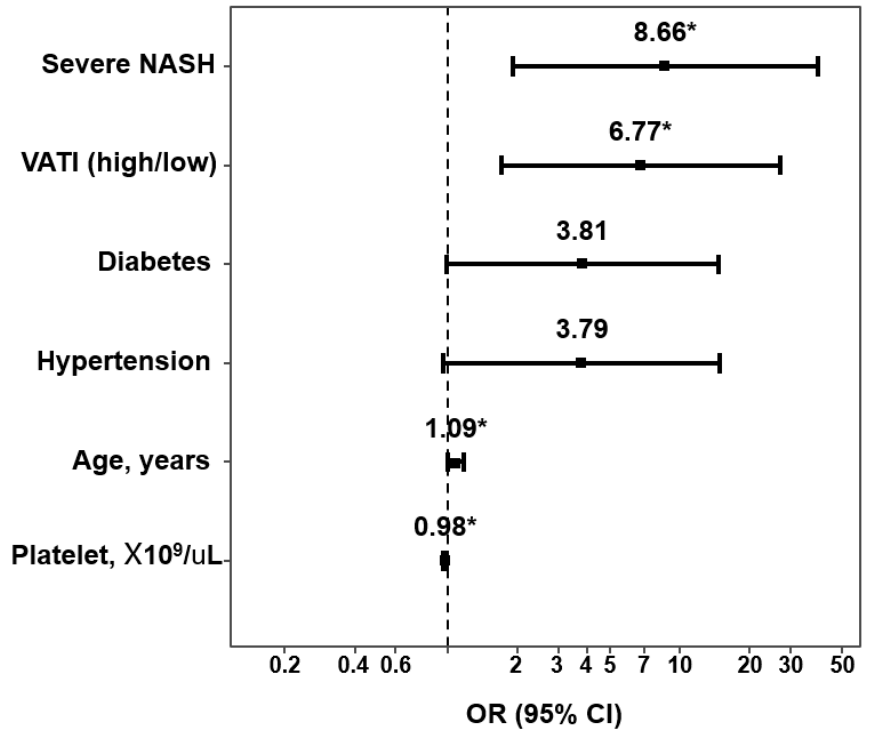
Figure 4. Risk factors for advanced fibrosis in patients with biopsy-proven non-alcoholic fatty liver disease in multivariate analysis. NASH, non-alcoholic fatty liver disease; VATI, visceral adipose tissue index. Asterisk means p < 0.05.